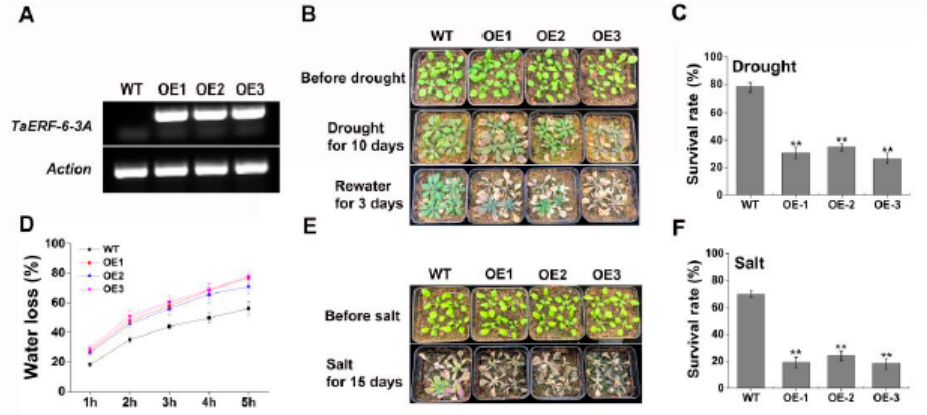
Figure 10. Functional characterization of TaERF-6-3A in transgenic Arabidopsis under drought and salt stress. ( A ) qRT-PCR verification of Arabidopsis overexpression (OE) lines. TaERF-6-3A specific primers were used to sense transgene levels. Arabidopsis Actin served as an internal control; The ( B ) phenotypes and ( C ) survival rates of TaERF-6-3A OE lines after withholding water for 10 days followed by resumption of watering for 3 days; ( D ) Water loss rates of 3-week-old OE lines; The ( E ) phenotypes and ( F ) survival rates of TaERF-6-3A OE lines after salt stress for 15 days. Standard deviations are indicated by error bars (mean ± SD and n = 3) and significant differences are indicated using asterisks (ANOVA, ** p <